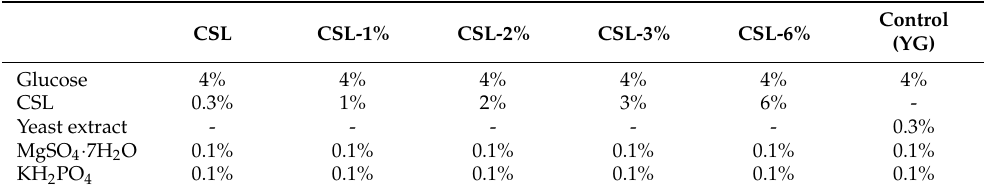
Table 2. Compositions of the media containing various concentrations of CSL. All media were adjusted to a pH of 5.5 ± 0.1.